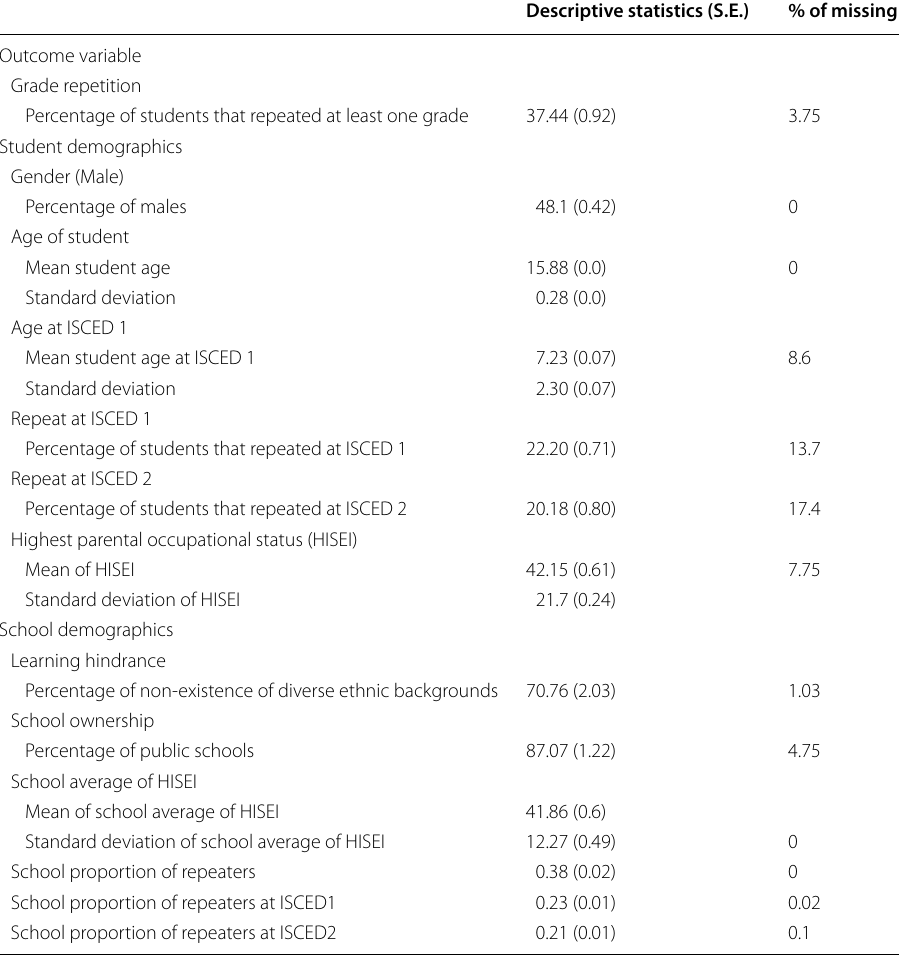
Source PISA 2012 data, authors’